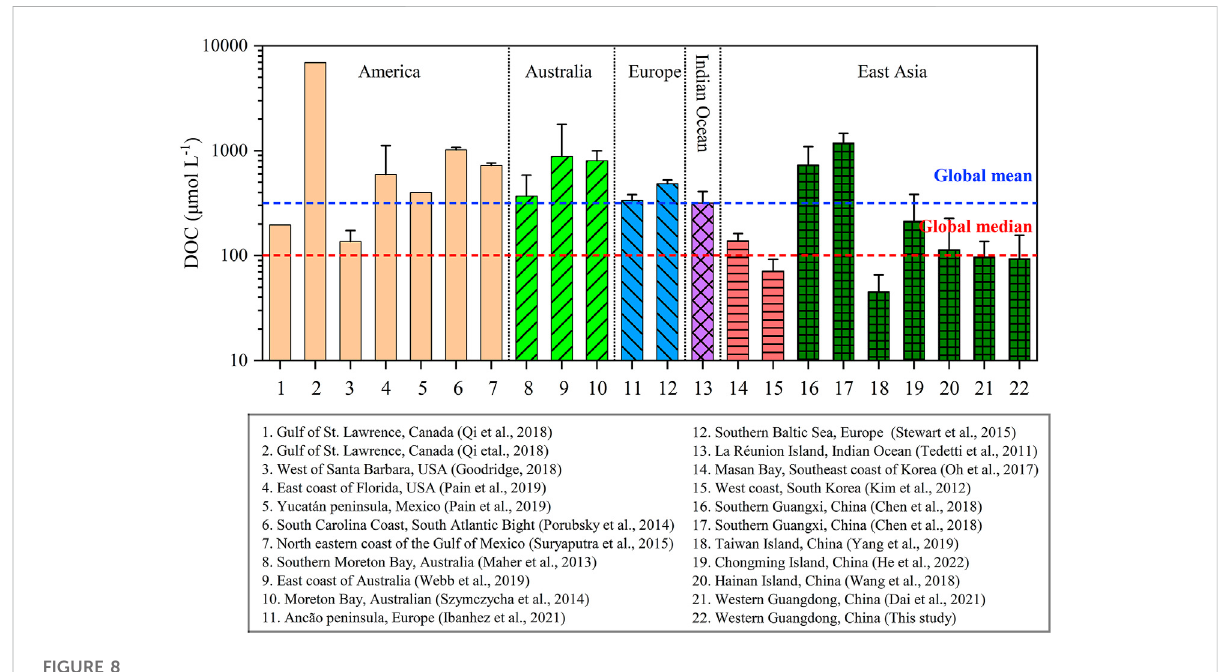
FIGURE 8 Histogram showing groundwater DOC concentrations in global coast regions. Error bars represent the standard deviations of multiple data for individual columns. Red and blue dashed lines indicate the global median and mean values of groundwater DOC concentrations ( n = 9,404), respectively, presented by McDonough et al.